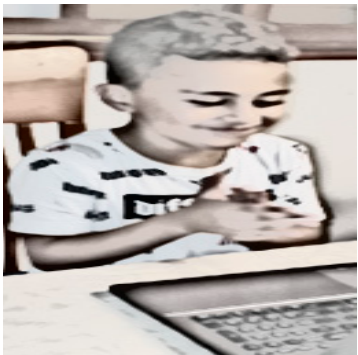
Figure 1. Ahmed’s reactions through Episode 1 of smiling and